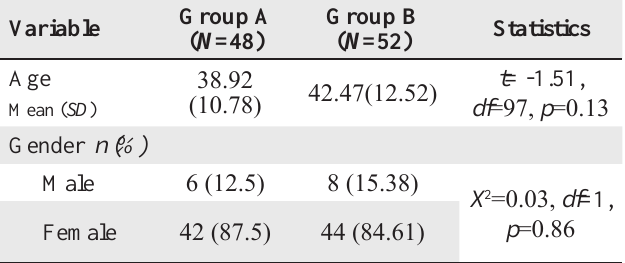
Table 1 : Demoghaphic characteristics of patients in two groups